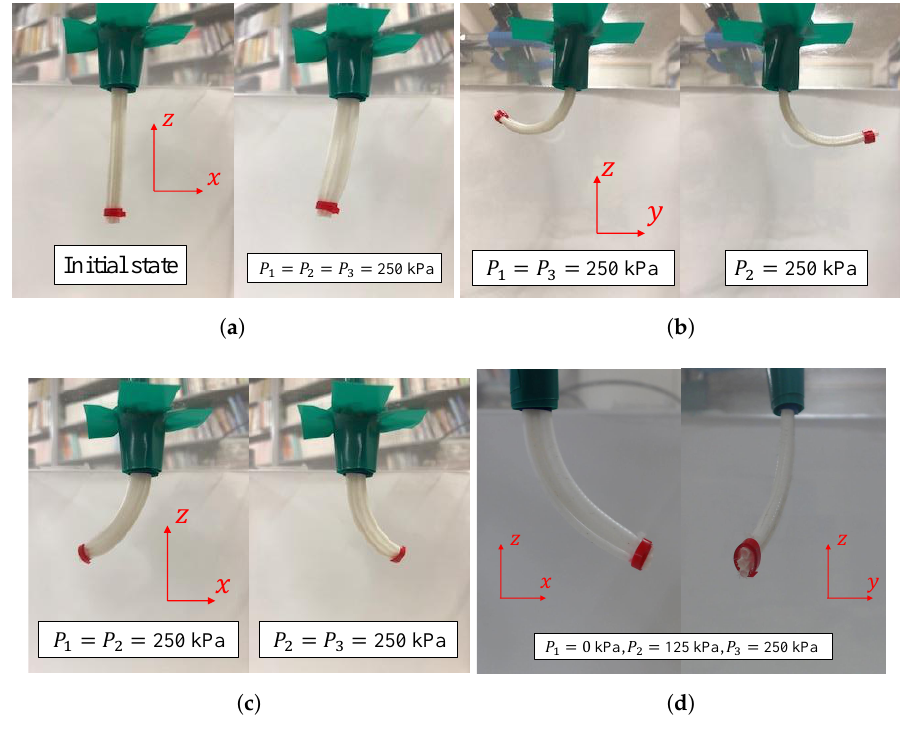
Figure 2. ( a ) Contracting motion toward z direction. ( b ) Bending motions in the y directions. ( c ) Bending motions in the x directions. ( d ) Bending motion when P 1 = 0kPa, P 2 = 125kPa and P 3 =